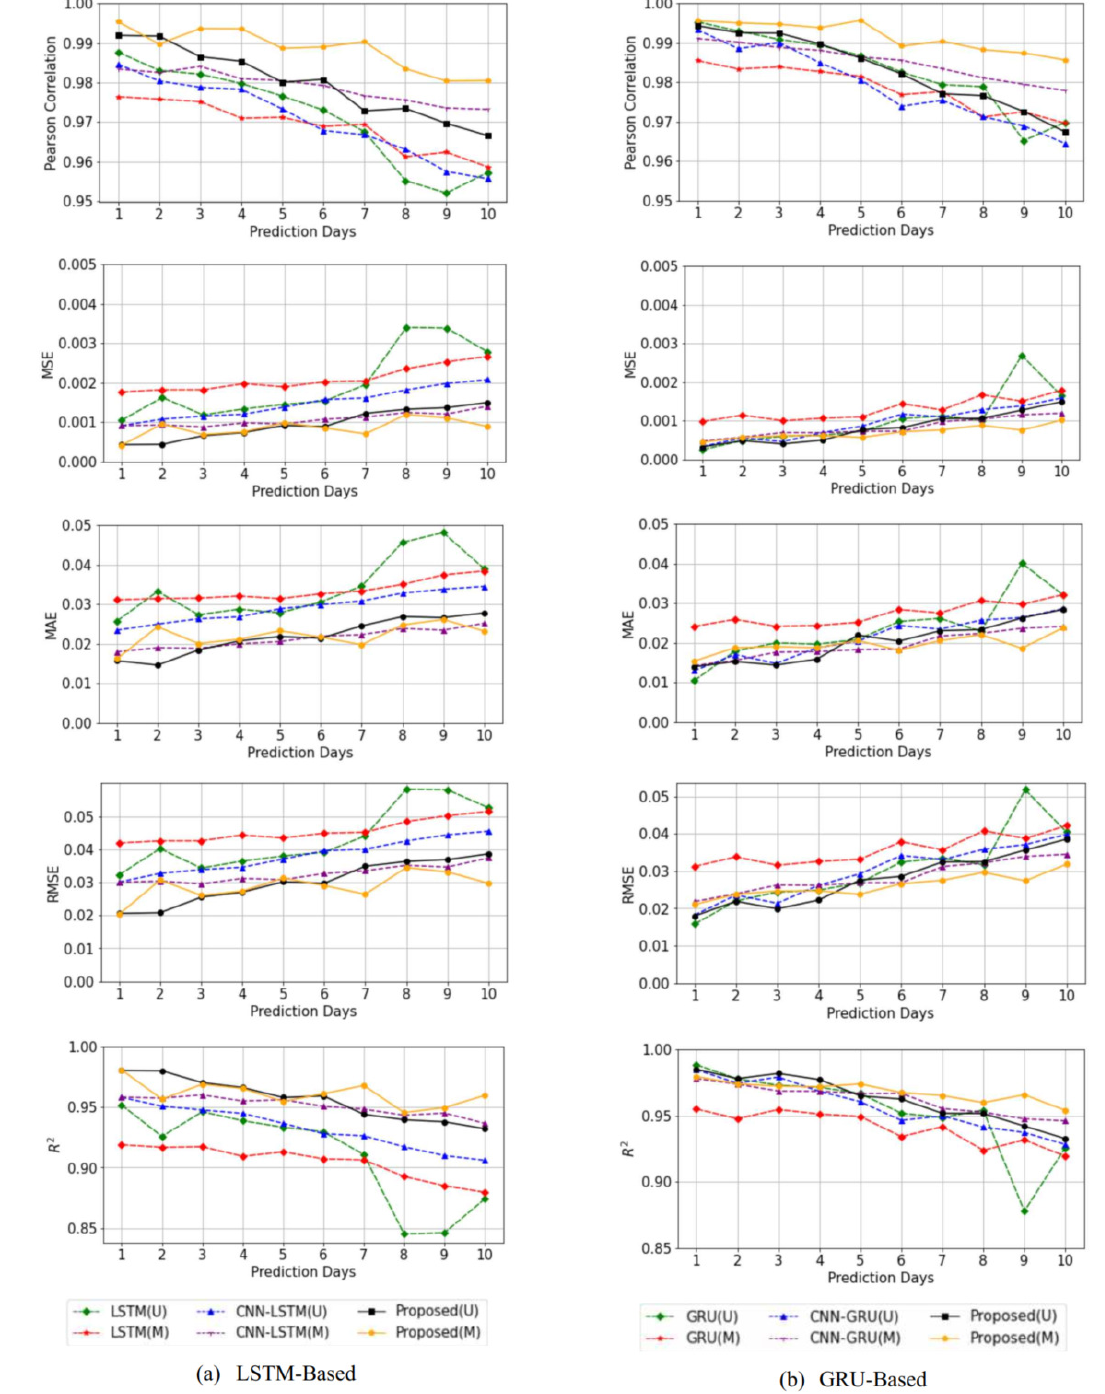
Figure 3. Comparison of the performance results of the LSTM and GRU models as a function of forecasting period up to 10